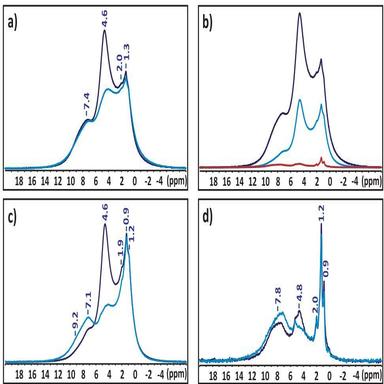
1H MAS NMR spectra (νr = 60 kHz, relaxation delay 10s) of (a) Dm-dentin before (black) and after (blue) vacuum drying, of (b) Dm-dentin (black) with short (0.76 ms, blue) and long (6 ms, red) dipolar filtering time (DF-SE), of Dm-dentin before (black) and after (blue) vacuum drying with short 0.76 ms (c) and long 6 ms (d) filtering time.